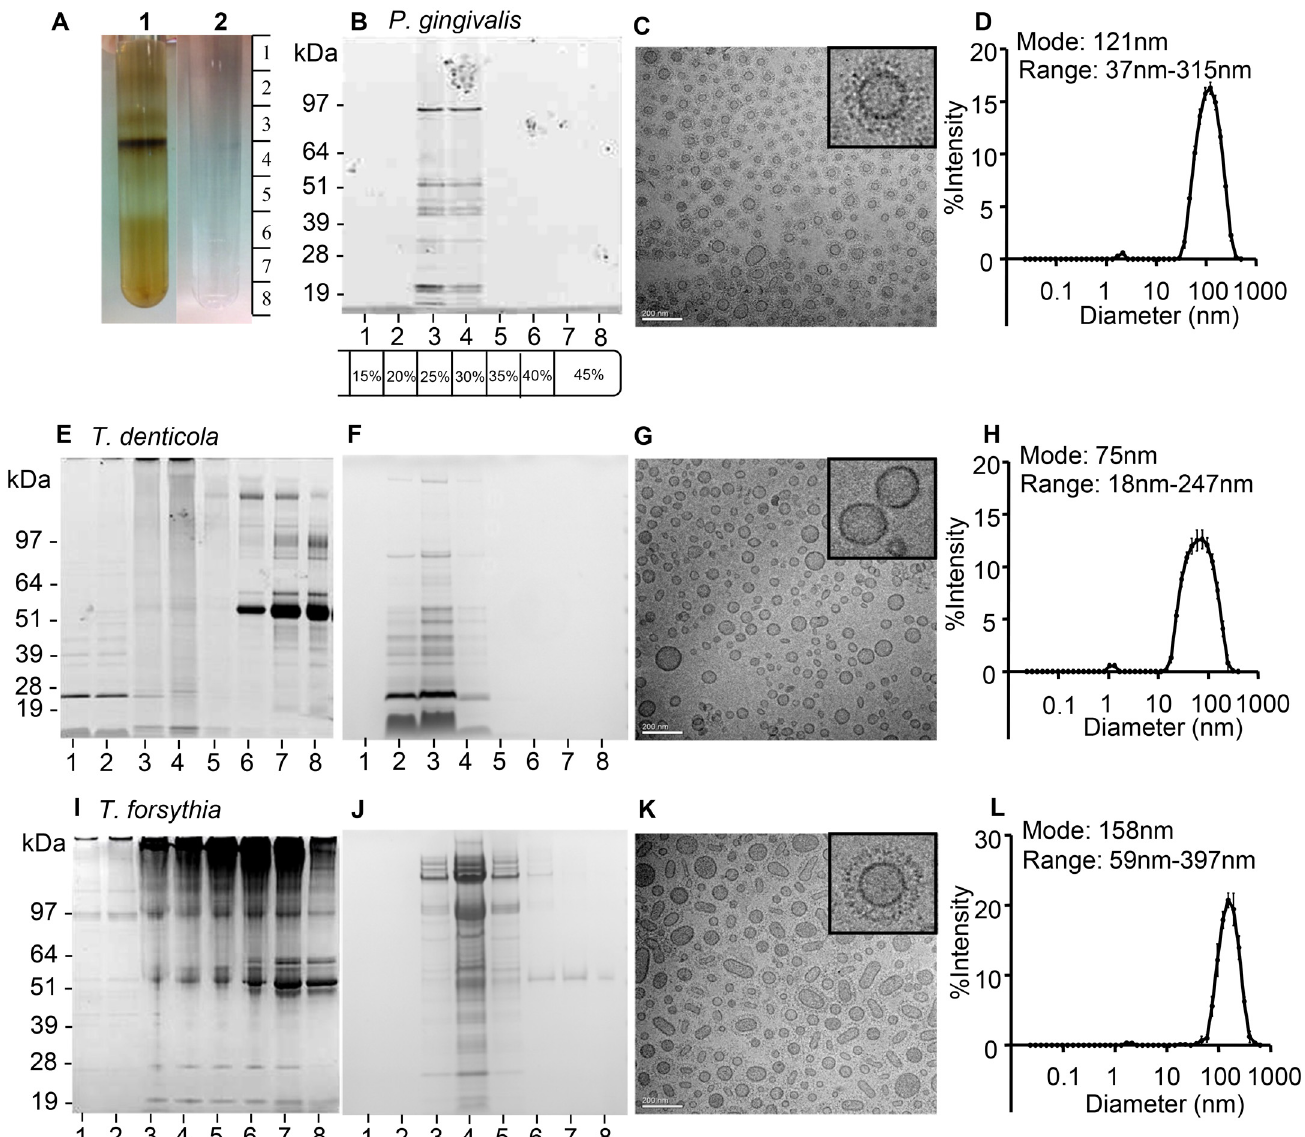
Fig 1. Isolation of highly purified P . gingivalis , T . denticola and T . forsythia OMVs. OptiPrep density gradient centrifugation of a crude T . forsythia OMV preparation (A1) separated non-OMV associated material (bottom of density gradient) from highly purified OMVs isolated at a higher density. A blank OptiPrep density gradient is shown in A2. SDS-PAGE of P . gingivalis (B), T . denticola (E F) and T . forsythia (I J) Optiprep density gradient fractions taken in eight 1.5 mL gradient fractions from top to bottom following centrifugation. Gradient fractions were subjected to SDS-PAGE and protein bands visualized by SimplyBlue or SyproRuby staining. Molecular mass markers (Novex SeeBlue Plus2 Prestained Standard) are indicated in kDa. OMVs were observed using transmission electron microscopy (TEM) (C G K). Vesicle size and range was further confirmed using dynamic light scattering (DLS) on pooled and washed OMV containing gradient fractions (D H